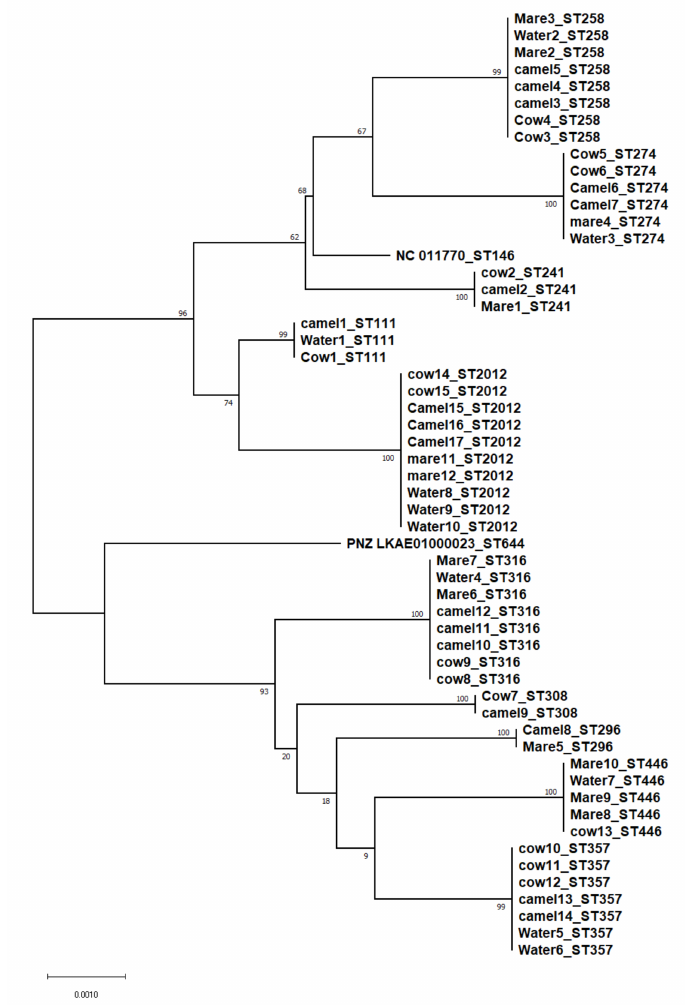
Figure 1. Unrooted phylogenetic trees using the concatenated sequences of the seven house- keeping genes of P. aeruginosa using the NJ method with the Kimura 2-parameter model for the distance calculations.